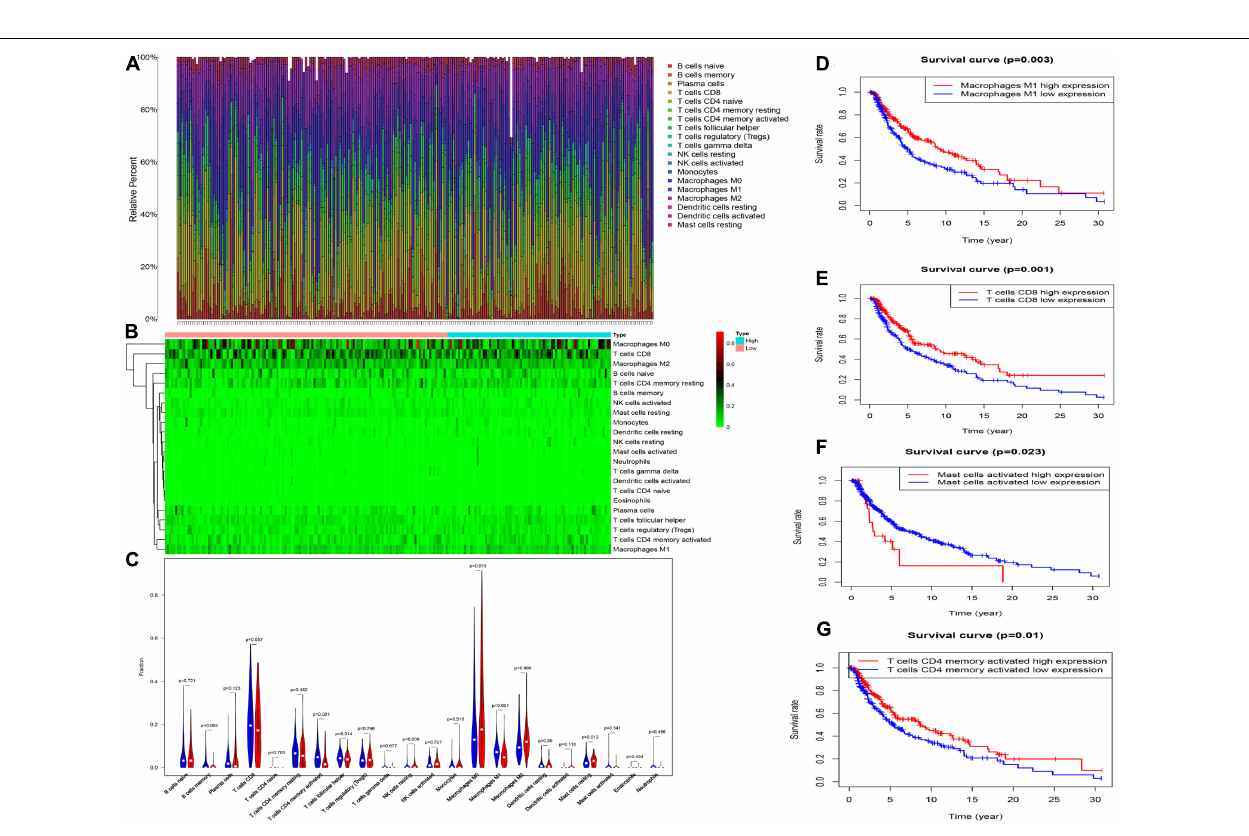
Frontiers in Cell and Developmental Biology |